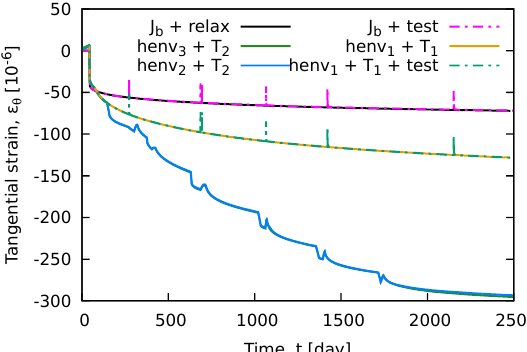
Figure 7. Evolution of hoop strain in the center of the wall - pressure tests.